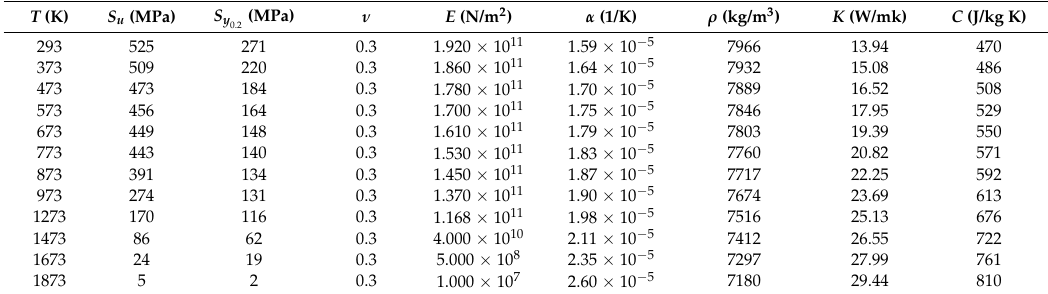
Table 3. The thermal and mechanical properties of the austenitic steel 316LN.